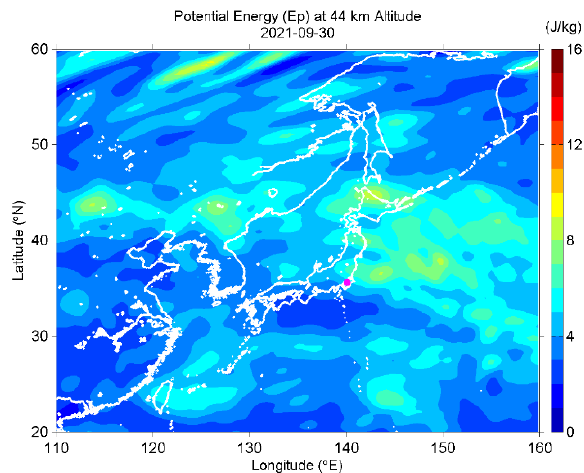
Figure 15. The E p map at 44 km altitude on 30 September.